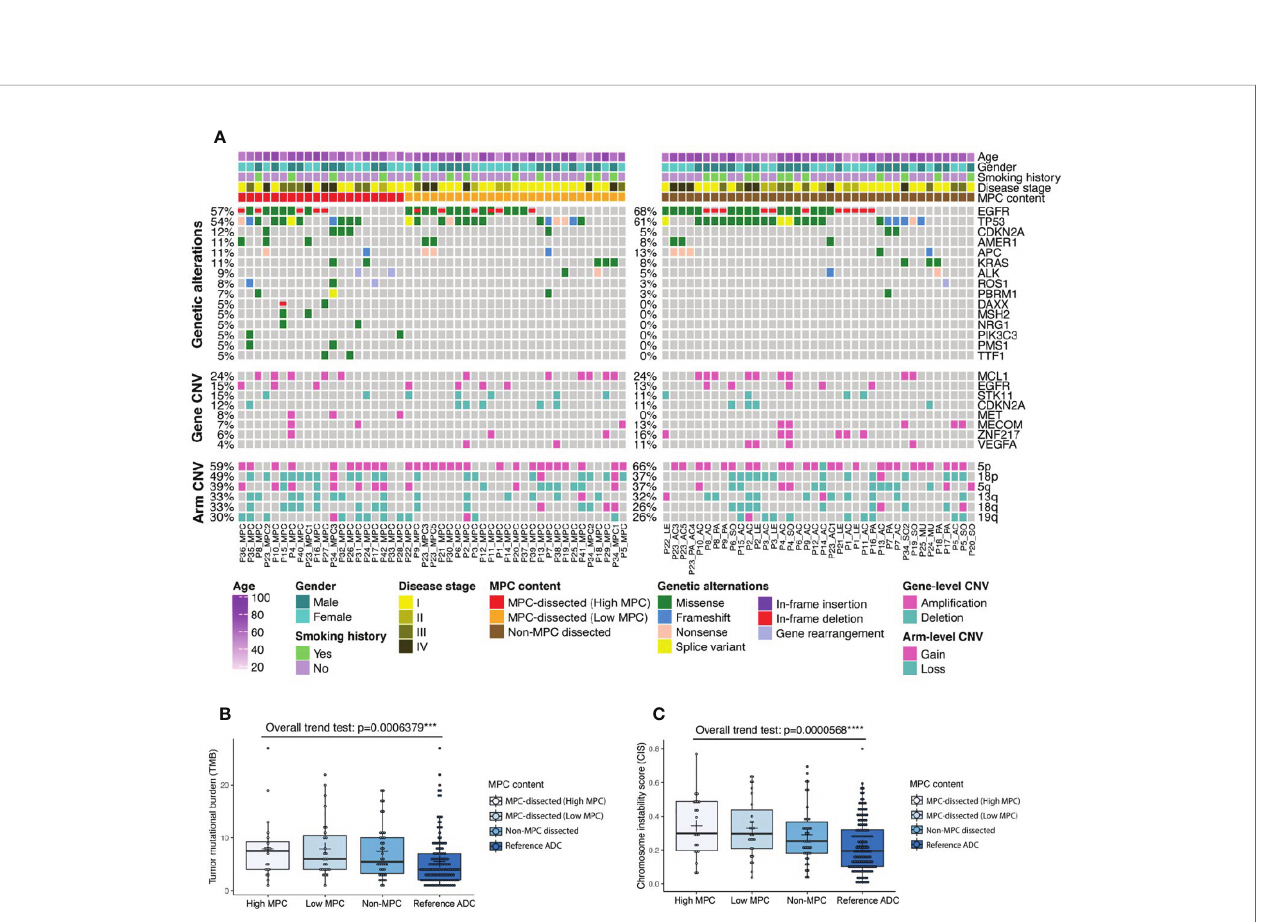
FIGURE 1 | Genetic characteristics of micropapillary component (MPC)-containing tumors within the discovery cohort. (A) Genetic alteration pro fi le of 43 MPC patients whose tumors were micro-dissected based on histologic subtypes and MPC content, including high MPC (30 – 100% of the original tumor), low MPC (0 – 20% of the original tumor), and the matched non-MPC regions. (B, C) The trend of tumor mutation burdens (TMB) (B) or chromosome instability score (CIS) (C) ranging from high MPC tumors, low MPC tumors, the matched non-MPC tumors to the reference LADC tumors.